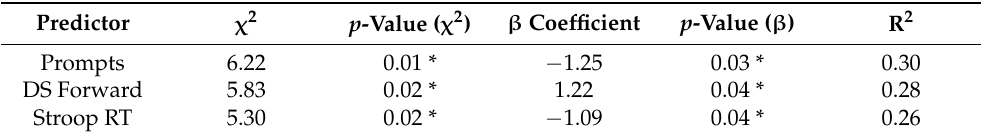
Table 6. Best generalised linear models for predicting ASD functionality